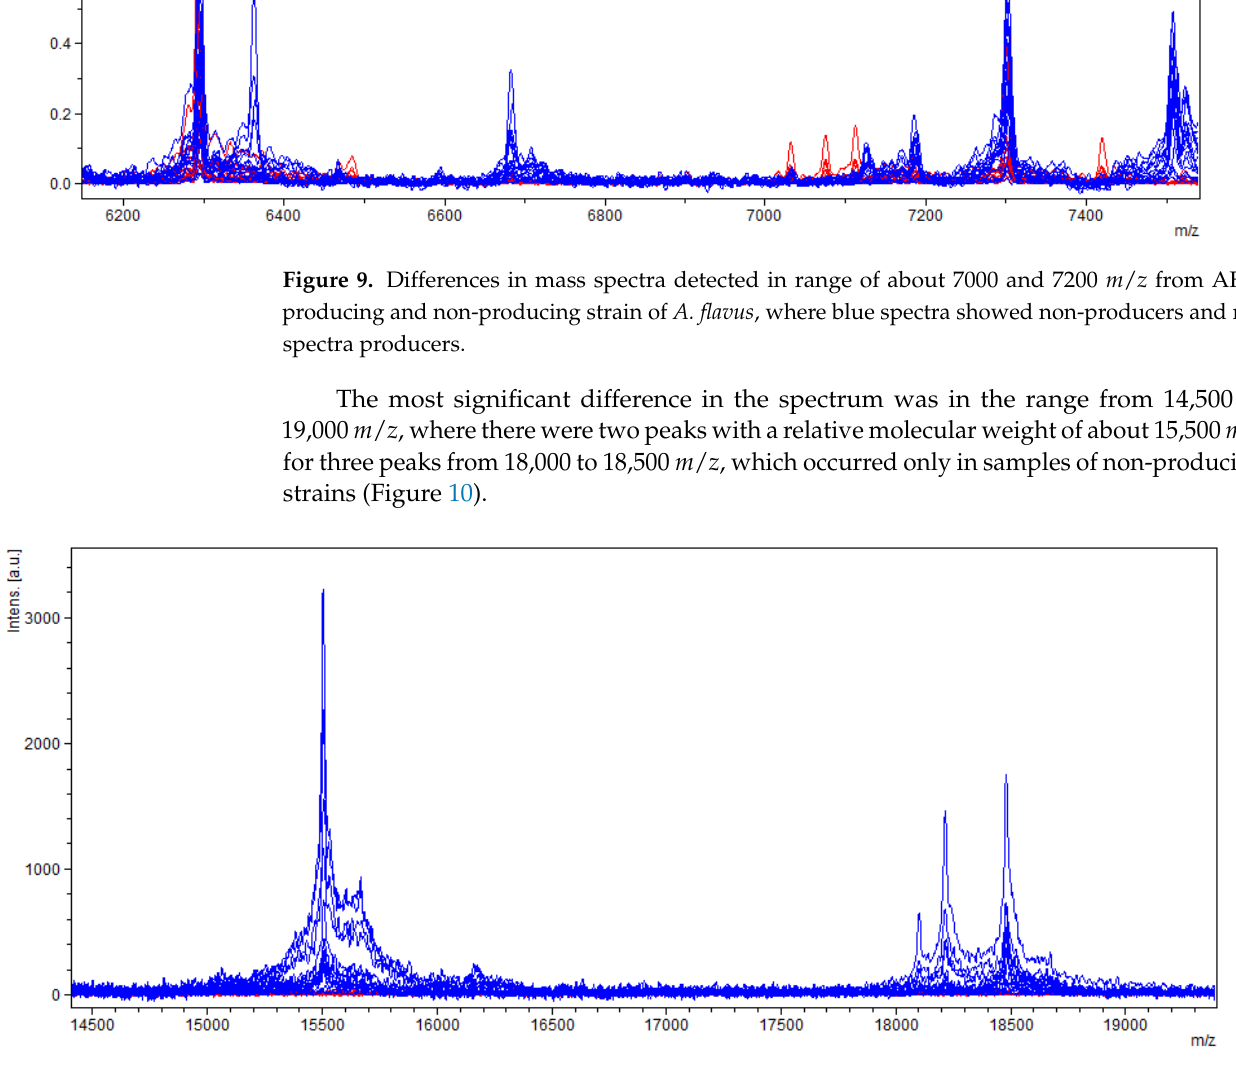
Figure 10. Differences in mass spectra detected in the range from 14.500 to 19.000 m/z from aAFB 1 producing and non-producing strain of A. flavus , where blue spectra showed non-producers and red spectra producers.